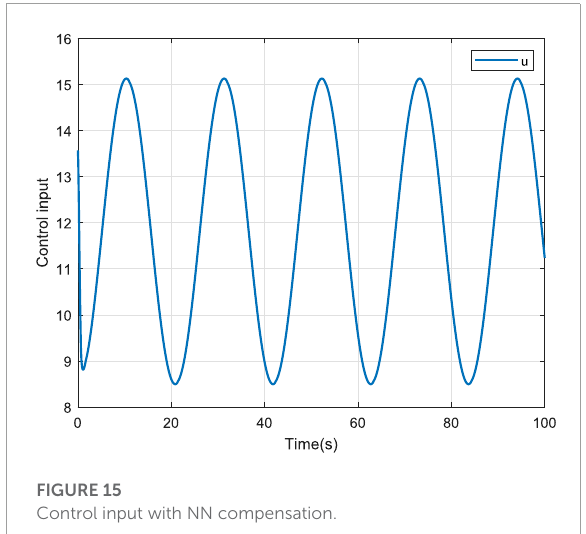
FIGURE 15 Control input with NN